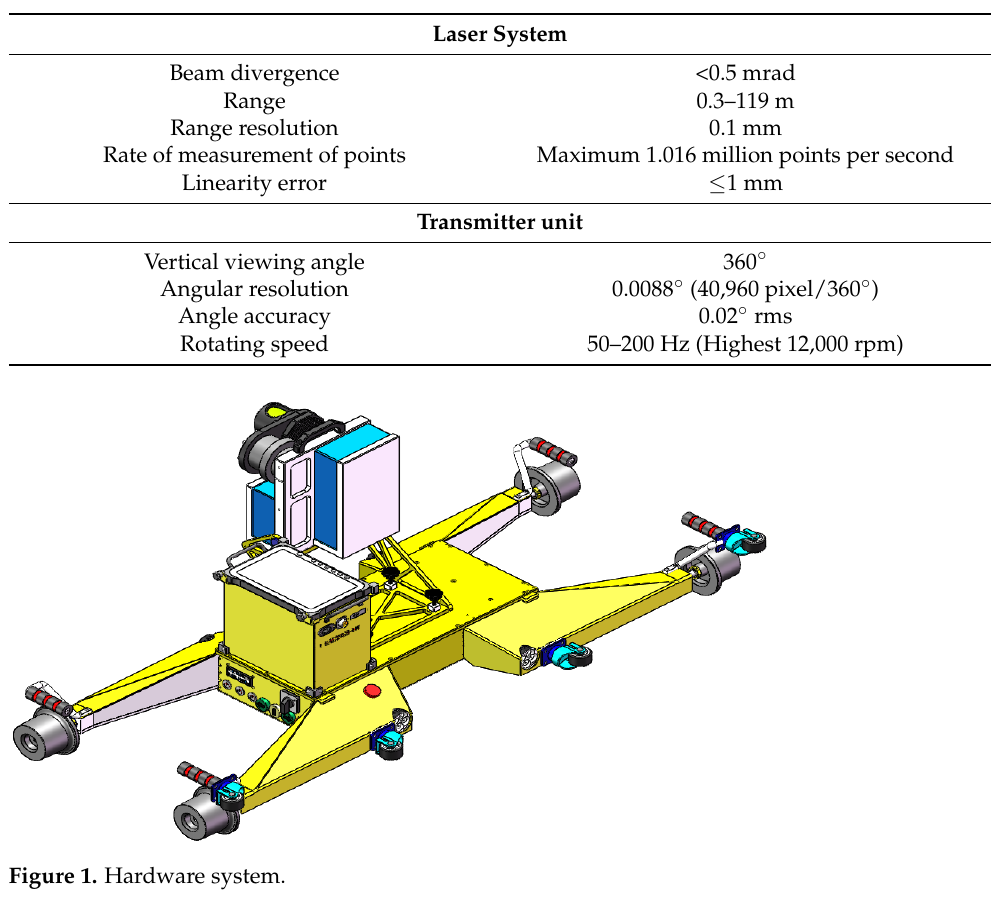
Table 1. Z + F 9012 laser scanner parameters.